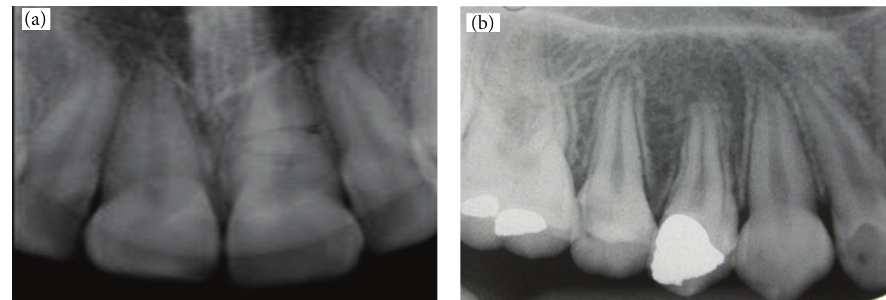
Figure 1: (a) Teeth with no decay and restoration. (b) Three teeth with decay and restoration.